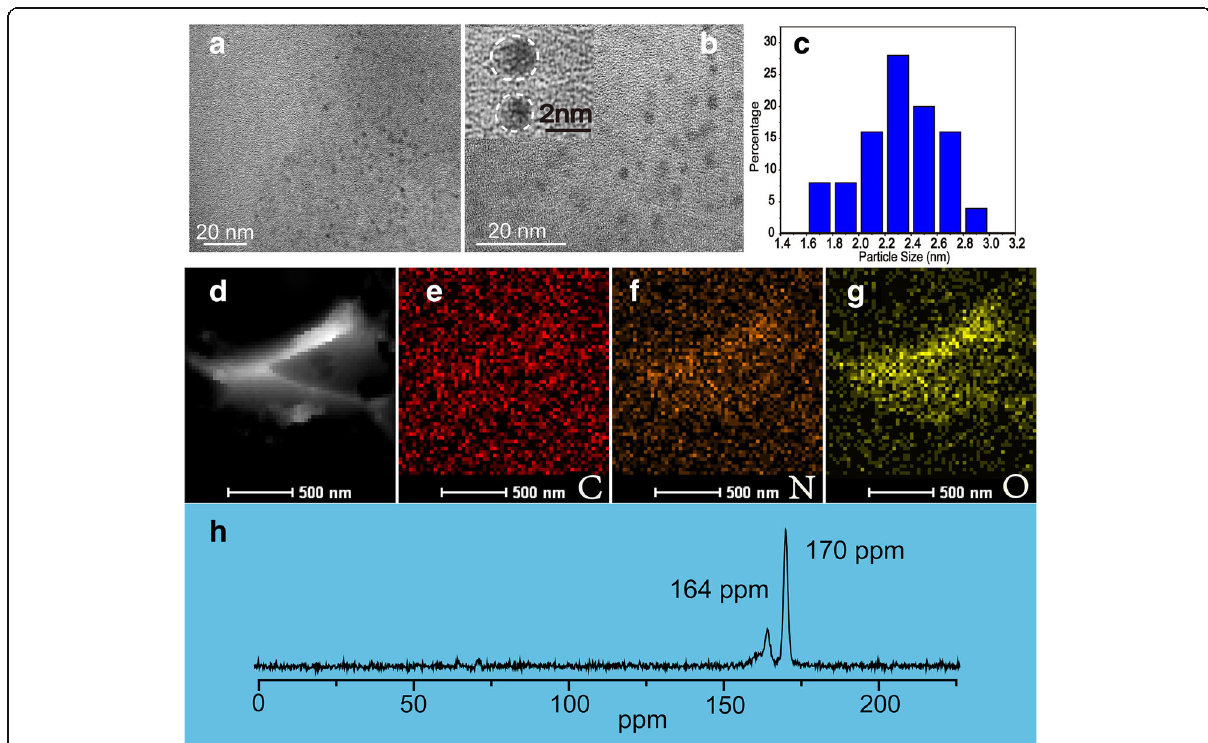
Fig. 1 TEM images of the NBDs ( a ) and ( b ). c The particle size distribution of the NBDs. HAADF image ( d ) and corresponding elemental distribution mapping of carbon ( e ), nitrogen ( f ), and oxygen ( g